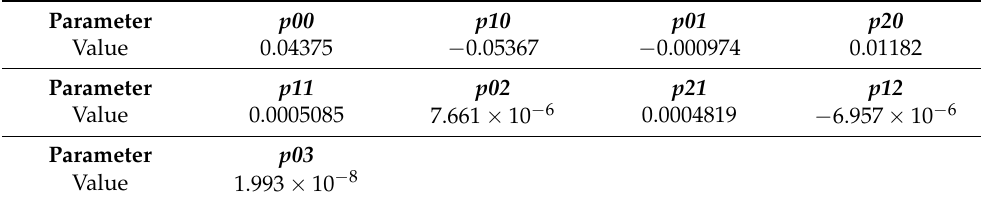
Table 4. Correlation parameters between RC Network R 1 and SOC/internal temperature.